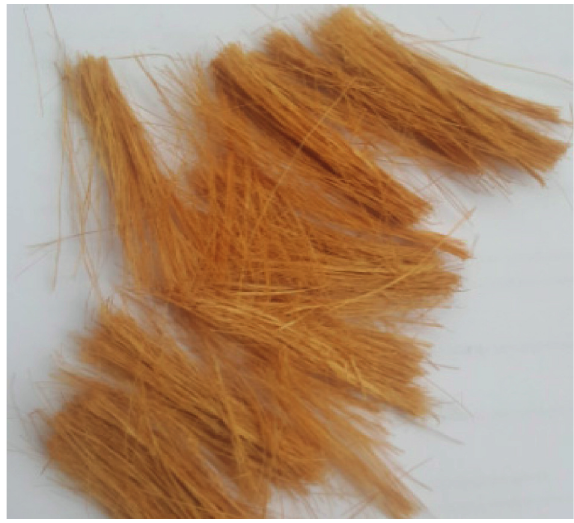
Figure 2: Cut banana fibres. Table 4: Geometry and mechanical characteristics of banana fibres.